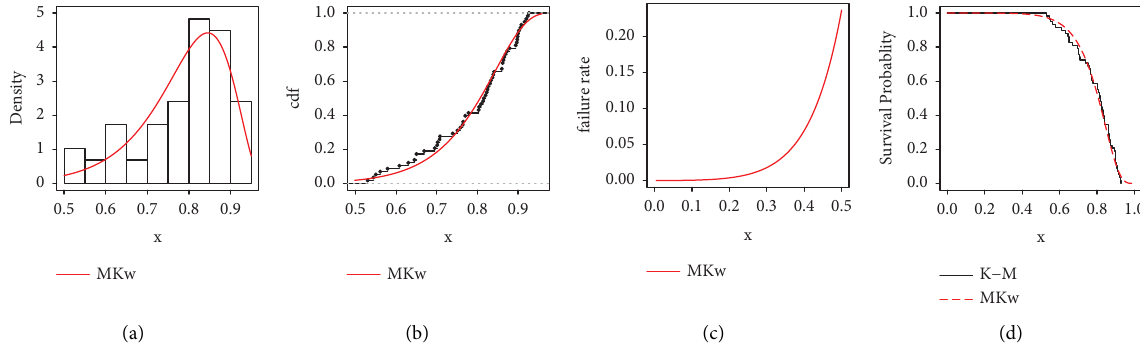
Figure 11: Plots of estimated pdf, estimated cdf, estimated hrf, and failure rate for data set 5.